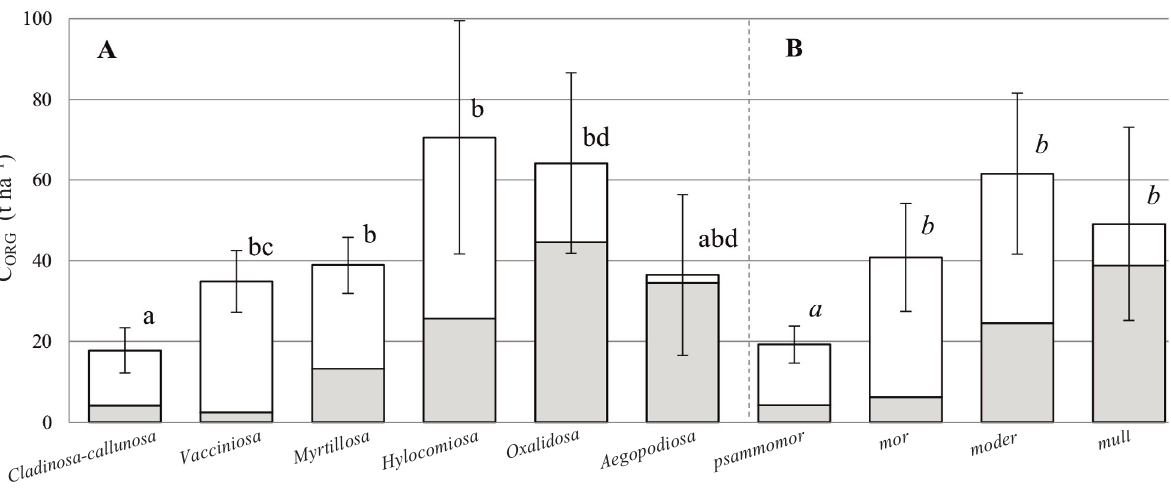
Fig. 2. Mean C stock and distribution in topsoil in different types of forests formed on dry mineral soils ( A ) and humus forms ( B ) ORG in Latvia: in white – the C stock in the O horizon; in grey – the C stock in the A (AE, EA) horizon. Vertical bars show standard ORG ORG deviations of the mean; small letters indicate statistically significant ( p > 0.05) differences between types of forest (regular letters) or humus forms (italic letters) according to Tukey’s